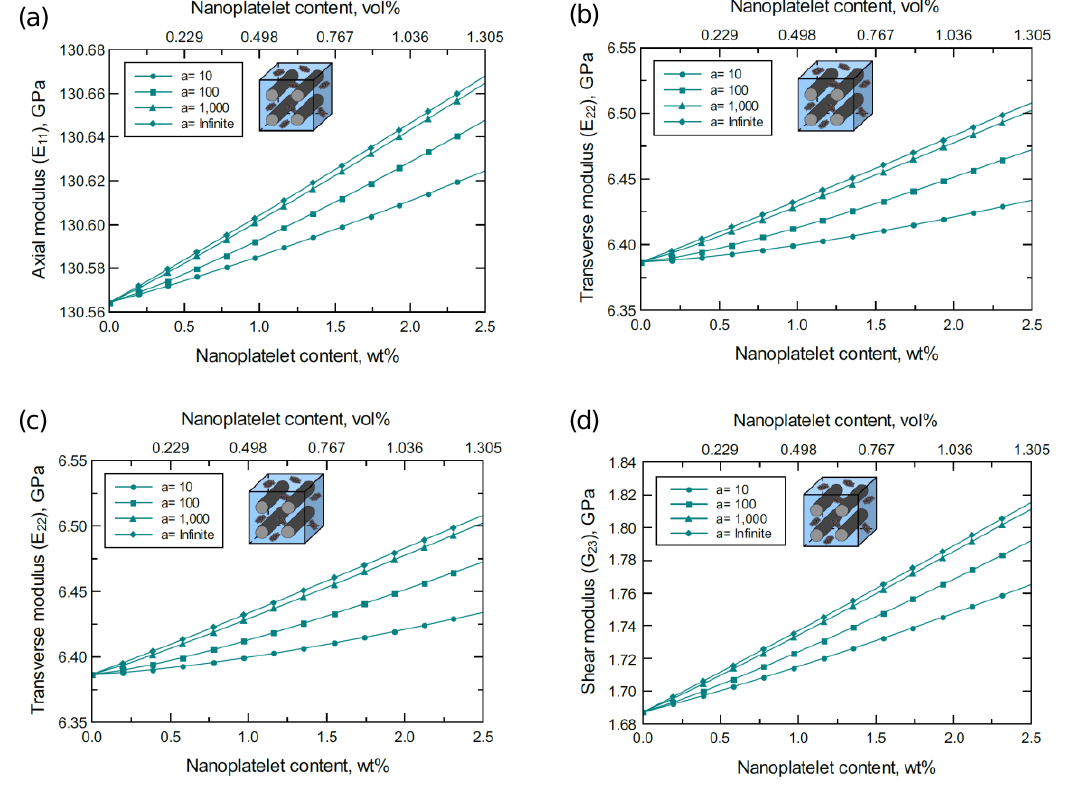
Figure 7. Predicted elastic and shear moduli for unidirectional CF/GO/epoxy for various nanoplatelet content and aspect ratio values; ( a ) axial elastic modulus E 11 , ( b ) transverse elastic modulus E 22 , ( c ) shear modulus G 12 , ( d ) shear modulus G 23 . The volume fraction of CF is 56%.